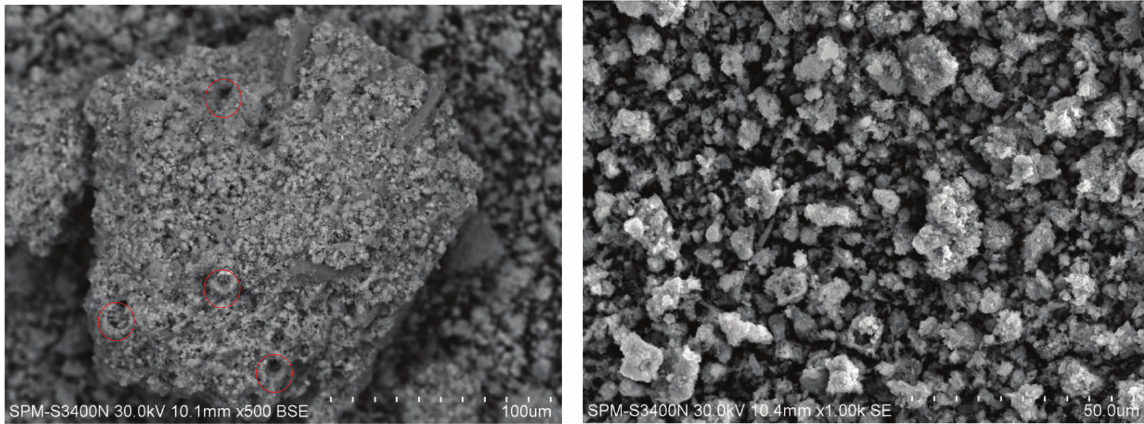
Figure 12: SEM images of the products after removal of chlorine; red circles show the reaction